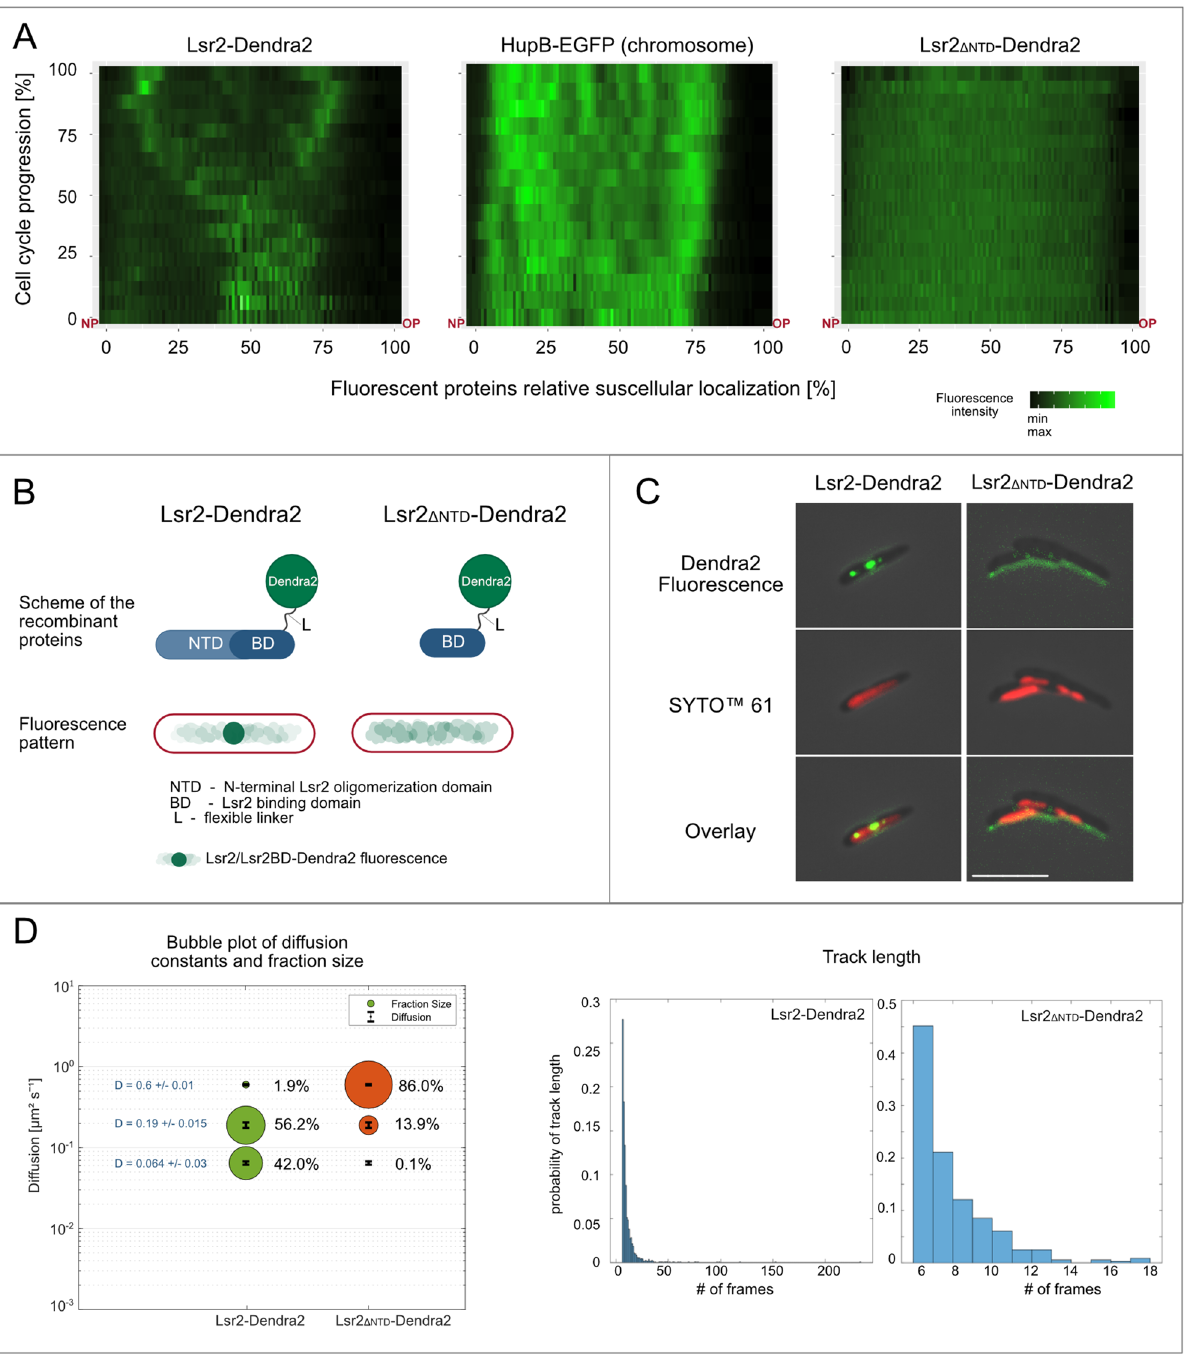
Figure 5. The influence of the N-terminal oligomerization domain on the subcellular localization and DNA binding of Lsr2. ( A ) Fluorescence profiles of Lsr2 ΔNDT -Dendra2, HupB-EGFP (chromosome), and Lsr2-Dendra2 during the cell cycle (n = 5). The truncated version of Lsr2 is observed as diffused fluorescence along the cell. NP new pole, OP old pole. ( B ) Graphic representation of full-length and truncated Lsr2 fused with Dendra2 (top panel). Fluorescence patterns of both proteins in M. smegmatis cells (bottom panel). ( C ) Microscopic images of representative Lsr2-Dendra2 and Lsr2 ΔNDT -Dendra2 cells stained with the nucleic acid dye, SYTO™ 61. Bar 5 µm. ( D ) PALM analysis of the mobilities of Lsr2-Dendra2 and Lsr2 ΔNDT -Dendra2 particles. The bubble plot comparison of diffusion constants and fraction sizes shows that the ratio of diffusing versus immobile particles was higher for the truncated form than for the full-length protein (left panel). The histograms represent the track length of full-length and truncated